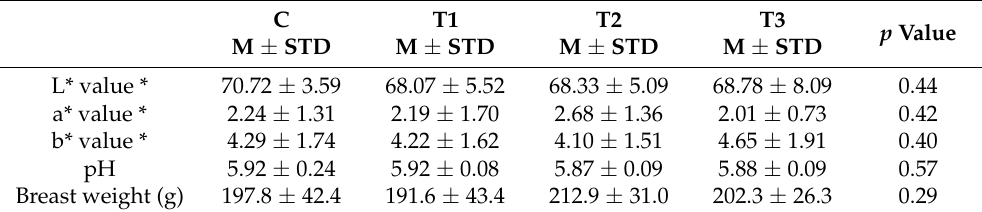
Data are reported as means (M, n = 21/group) and standard deviations (STD). Treatment C: basal ration as a control group, treatment T1: basal ration supplemented with 350 mg/kg of thyme essential oil, treatment T2: basal ration supplemented with 350 mg/kg of oregano essential oil, treatment T3: basal ration supplemented with 350 mg/kg of thyme and oregano essential oils in equal proportions. * The color trait (CIE L* = lightness, a* = redness, and b* = yellowness)